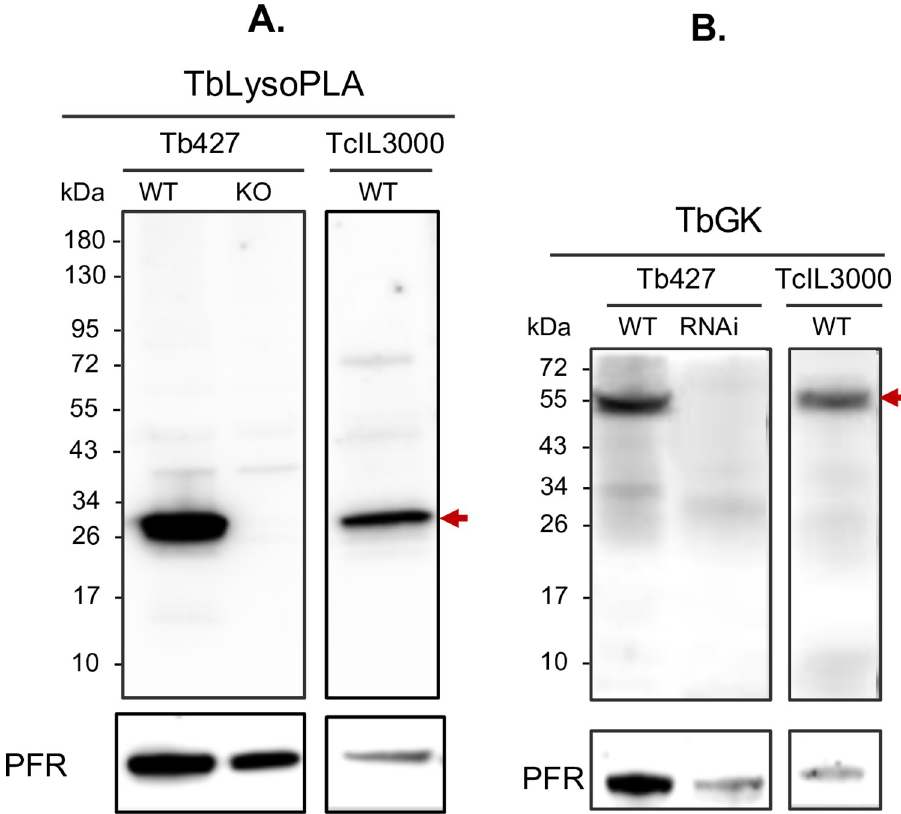
Fig 1. Cross-detection of TbLysoPLA and TbGK orthologs on T. congolense total extract by western blot. Western blot analysis of TbLysoPLA (A.) and TbGK (B.) in wild type (WT) parasites (Tb427 and TcIL3000), in Δ TbLysoPLA KO (knockout of TbLysoPLA gene) and Δ TbGK RNAi (RNA interference of TbGK mRNA in Tb427). The PFR (Paraflagellar Rod) protein was used as loading control.